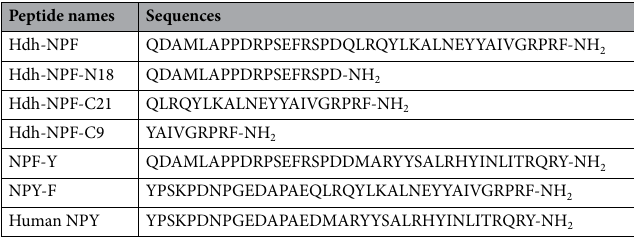
Table 1. Amino acid sequences of peptides.